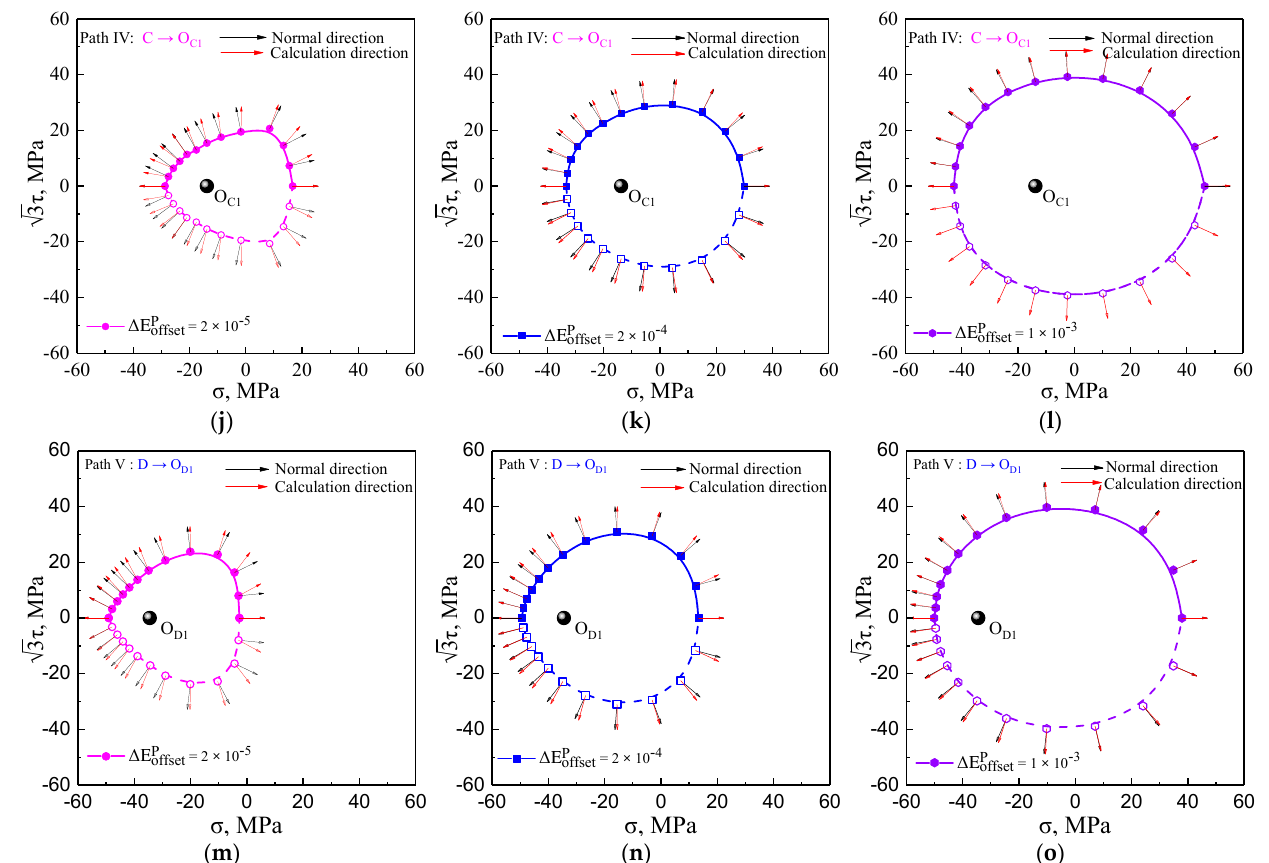
Figure 11. The plastic flow directions by theoretical calculations and simulated results with the offset strain of 20 μ , 200 μ , and 1000 μ under five unloading cases: ( a – c ) at unloading points O A1 ; ( d – f ) at unloading points O A2 ; ( g – i ) at unloading points O B1 ; ( j – l ) at unloading points O C1 ; ( m – o ) at unloading points O D1 .